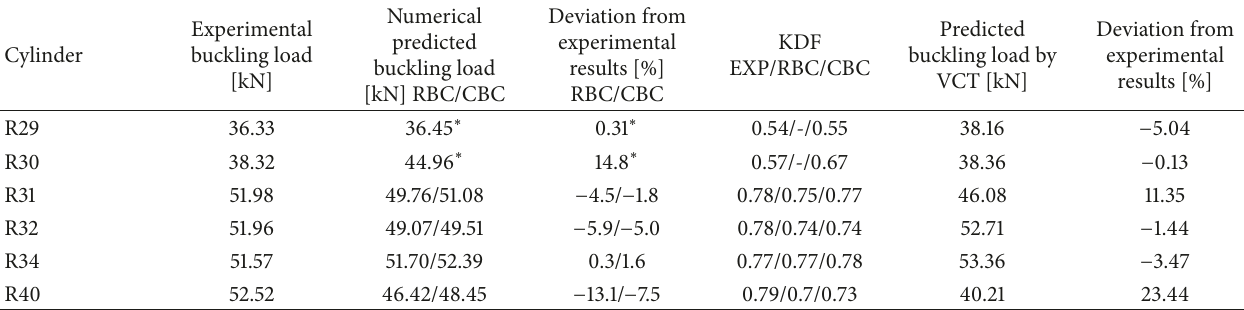
Table 4: Numerical buckling load prediction and VCT results for shells without